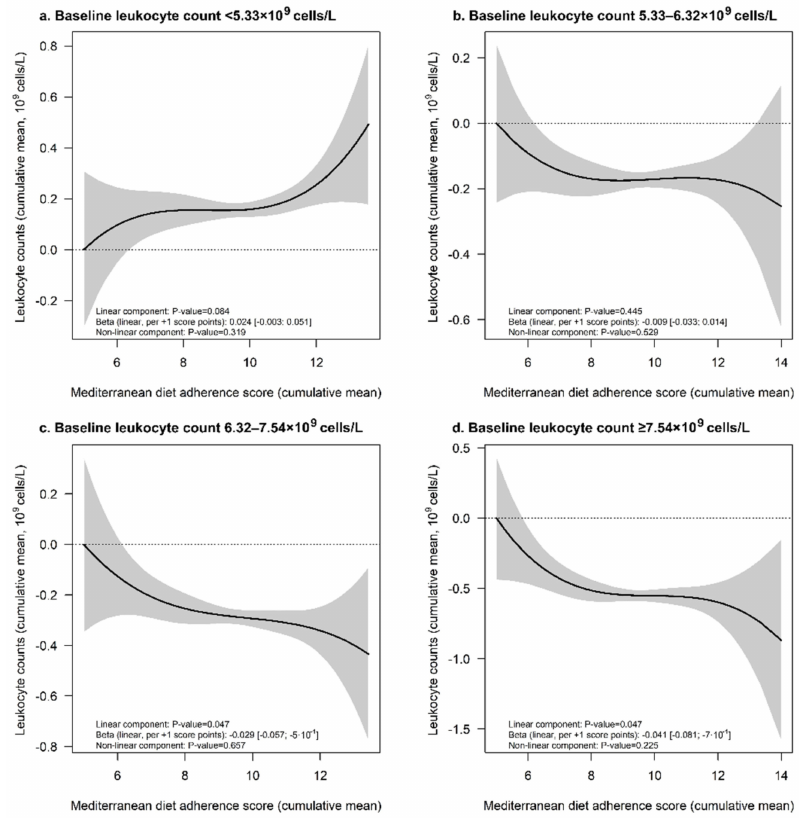
Figure 3. Associations between cumulative means of MedDiet adherence scores and white blood cell count throughout the study stratified according to baseline levels: first ( a ), second ( b ), third ( c ), and fourth quartiles ( d ). Dose-dependent associations between cumulative means of MedDiet adherence scores and cumulative means of white blood cells were estimated by multiple linear regressions with cubic spline models. Models were adjusted for white blood cell count at baseline, age, sex, recruitment site, educational level, diabetes, hypercholesterolemia, hypertriglyceridemia, hypertension, smoking habit, leisure-time physical activity, body mass index, hemoglobin levels, alcohol consumption (baseline values, all), and PREDIMED intervention